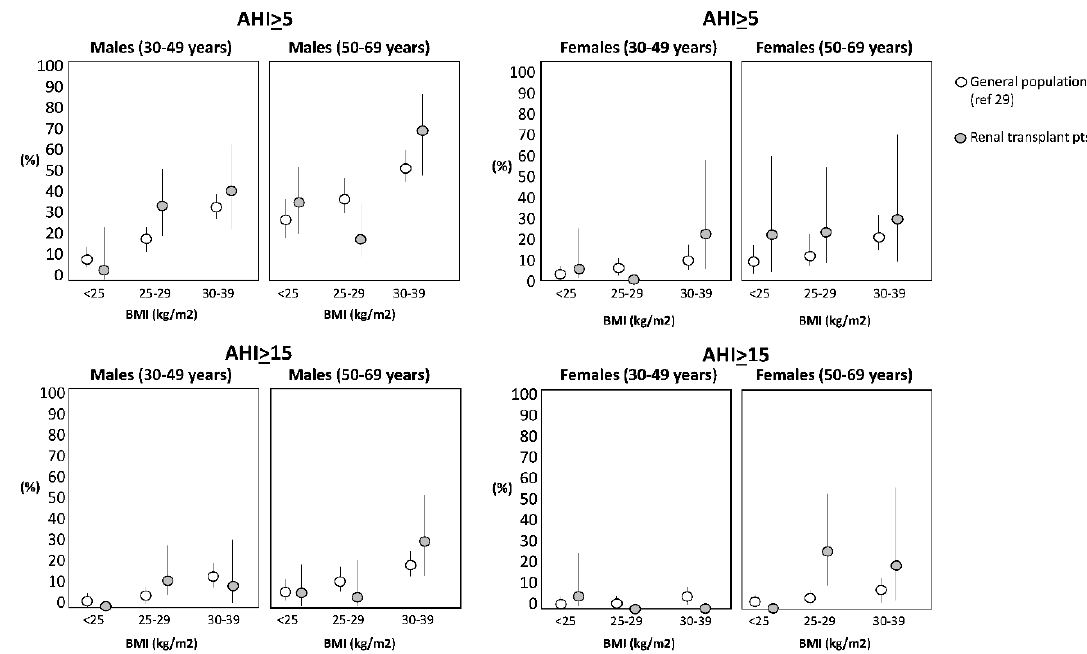
Figure 2. AHI stratified by gender, and BMI in transplant patients in the present study (grey circles) and in individuals in the general population (white circles) described in [29].